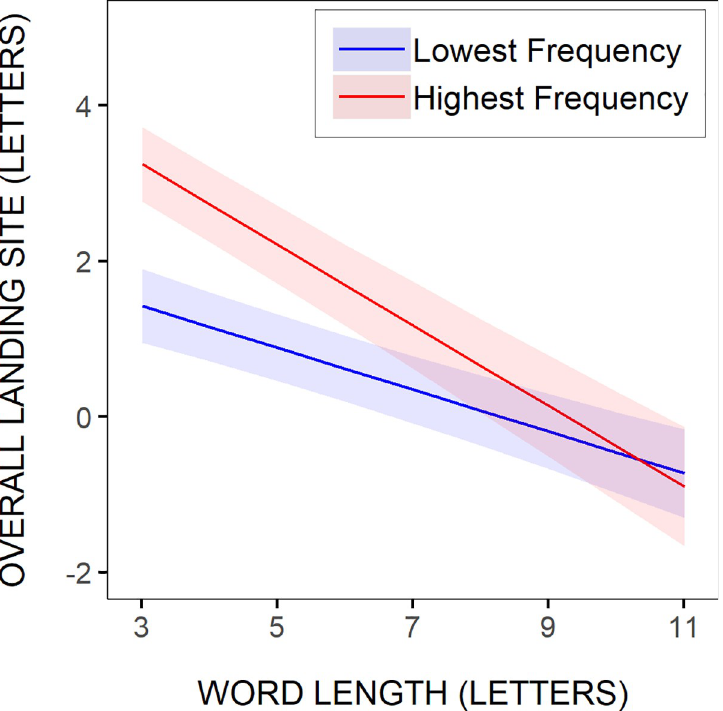
Fig 12. Estimated overall landing positions. Partial effects (with 95% confidence intervals) computed from LMM parameters (Table 8), representing saccades’ overall landing positions for all words in the sentences as a function of word length (in letters), separately for the two most extreme word-frequency values across all selected words (-2.66 and 9.59 log units respectively).